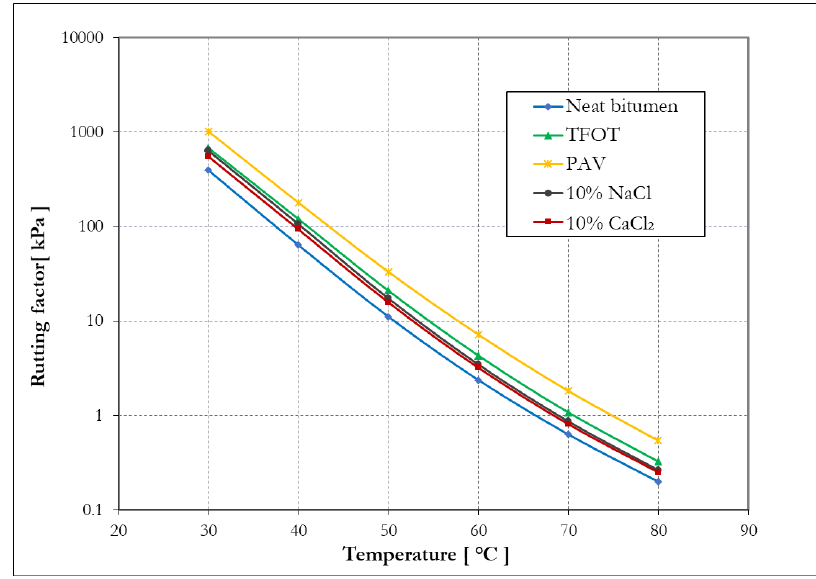
Figure 10. The rutting factor of bitumen before and after aging. Table 6. The failure temperature of five kinds of